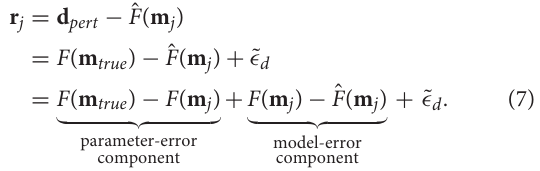
Algorithm 2 outlines the steps involved in our modified